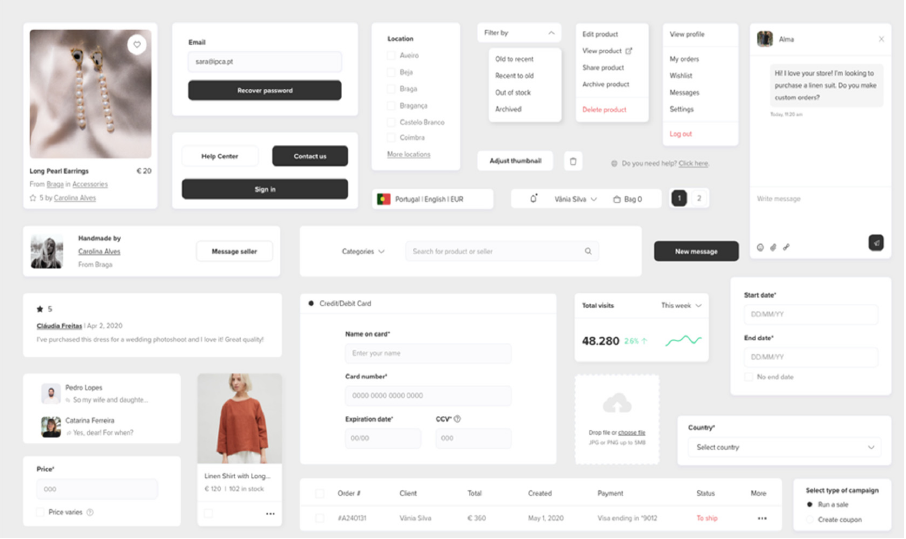
Figure 7. A selection of components for the prototype. Self-source, 2020.